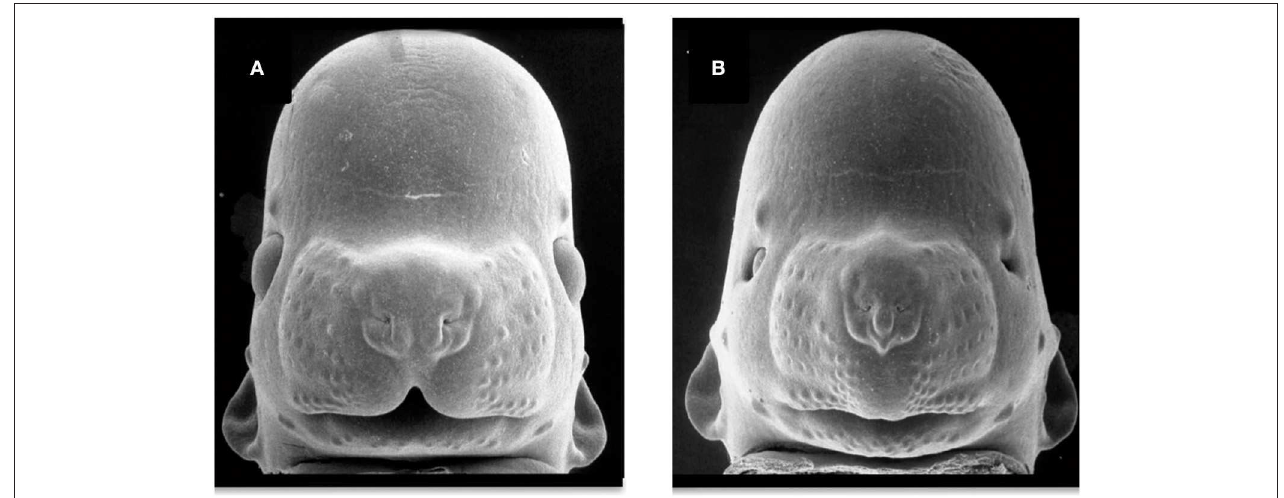
FIGURE 4 | Facial dysmorphology induced by prenatal ethanol exposure. Representative examples of a control animal (A) and a fetus severely affected by ethanol exposure (B) . FAS-like phenotype (B) is defined by microcephaly, short palpebral fissures, thin upper vermillion, and smooth philtrum. FAS-like facial features are induced in the mouse by maternal alcohol exposure on gestational day 7 and 8.5 (equivalent to the third gestational week in humans). Courtesy of Prof. Kathie Sulik, University of North Carolina-Chapel Hill (271)